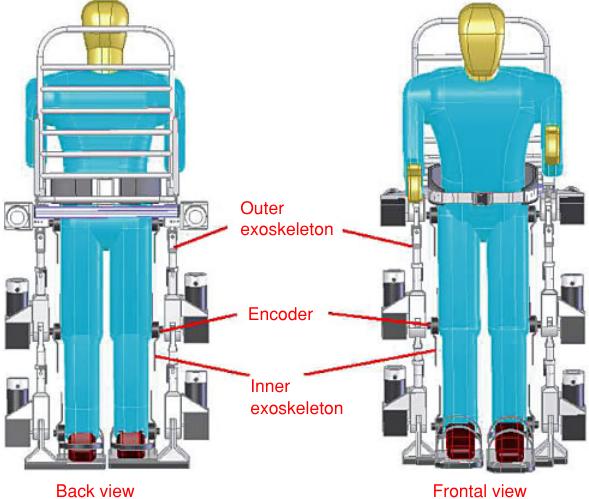
Figure 4 The inner and outer exoskeletons.